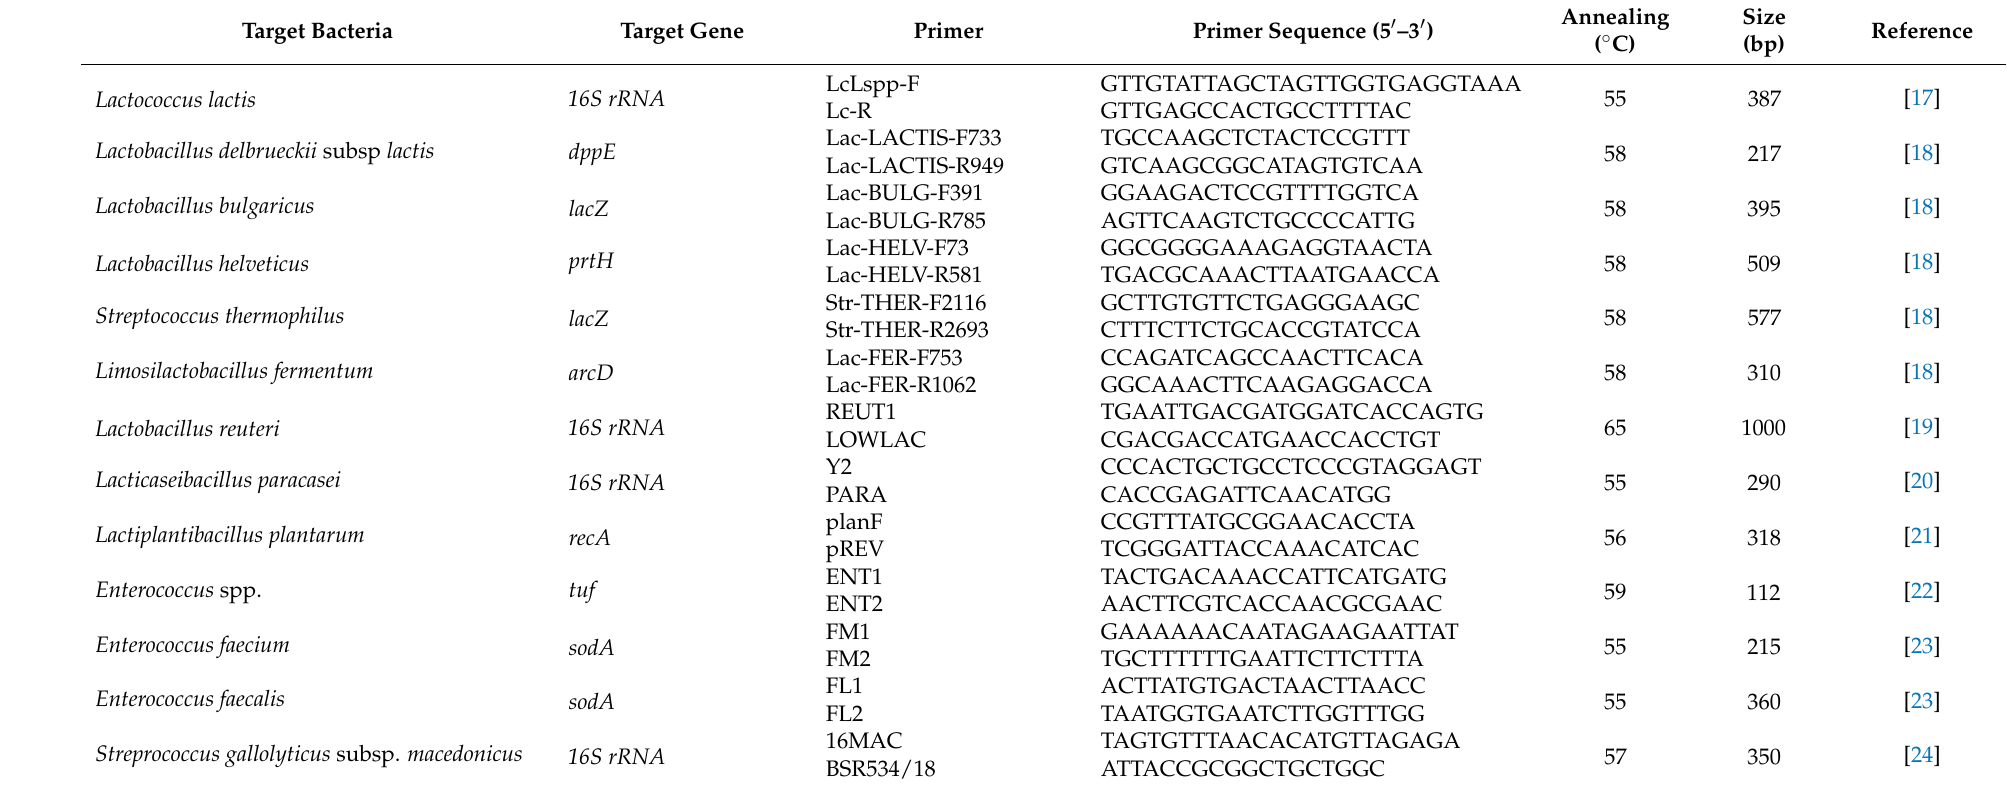
Table 1. Primers used in this study for the detection of target genes and